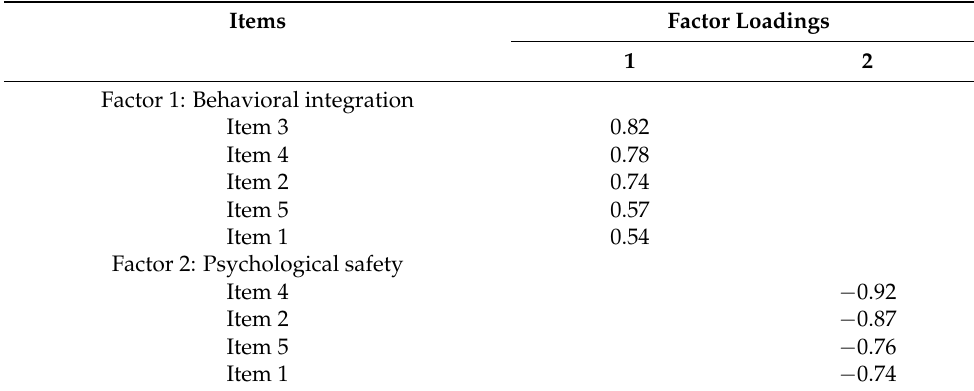
Table 2. Results from a principal component analysis of the two scales after removing Item 3 from the Psychological safety